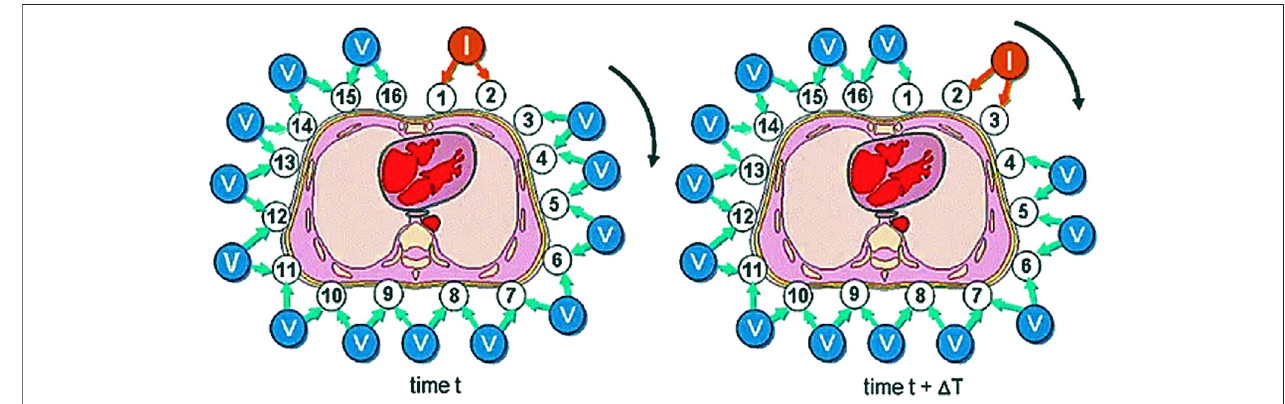
FIGURE5 | Working process ofthe adjacent driving mode (Leonhardt and Lachmann, 2012). After theselected set of excitation tests arecompleted, we replaced the excitation source electrodes in a clockwise direction and continue to measure the output voltage.